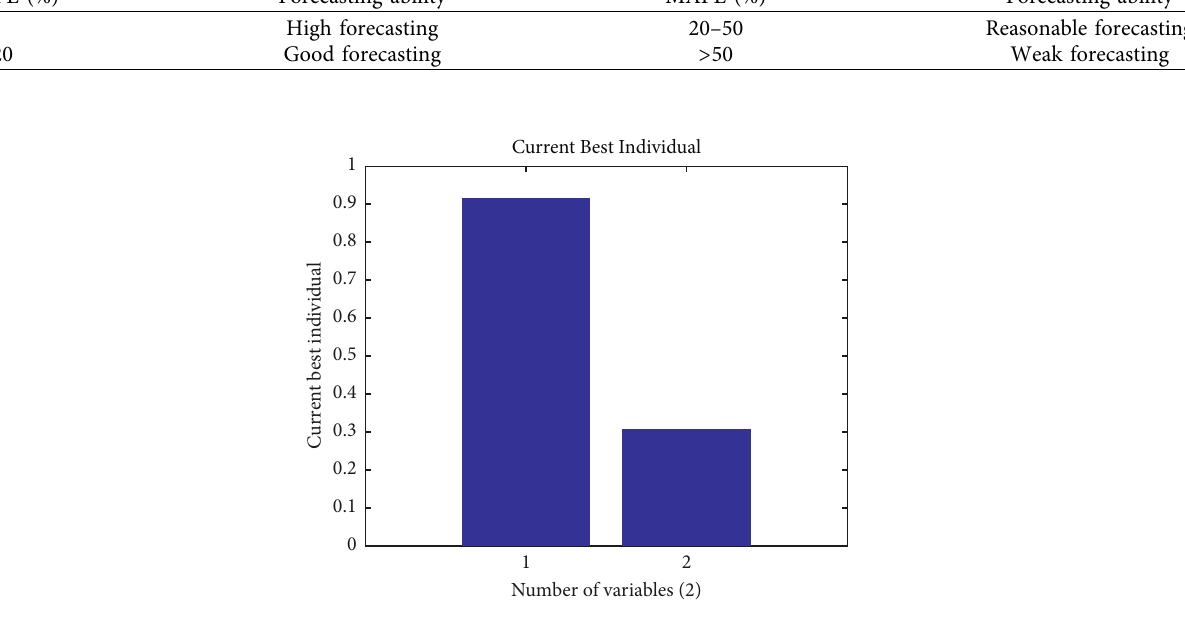
Figure 3: Optimal parameter